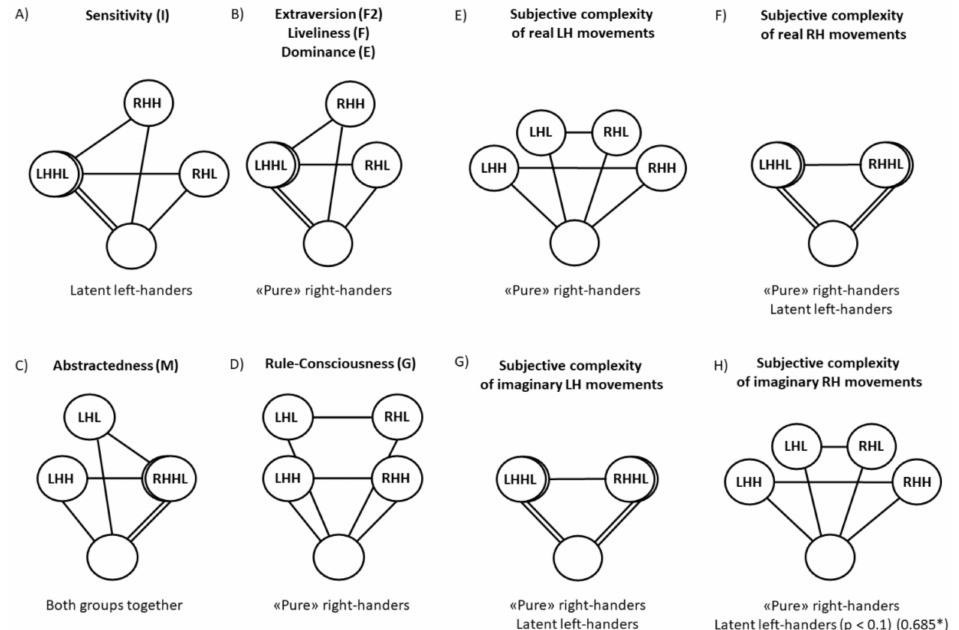
Figure 2. Scheme of the mutual location of areas of state of parameters calculated from EEG characteristics and used for classification, characterizing different brain states: at the rest (empty circles), while imagining movements of the right hand (RH) or left hand (LH) with low (L) or a high (H) value of an individual personality trait or subjective complexity of real or imaginary movements among “pure” right-handers, latent left-handers and both groups together. The distance between circles corresponds to the classification accuracy of brain states. p -value and Pearson correlation coefficients (in parenthesis with an asterisk) are indicated in a case of Spearman trend (Figure 2H). The description and explanations for the figure are given in the